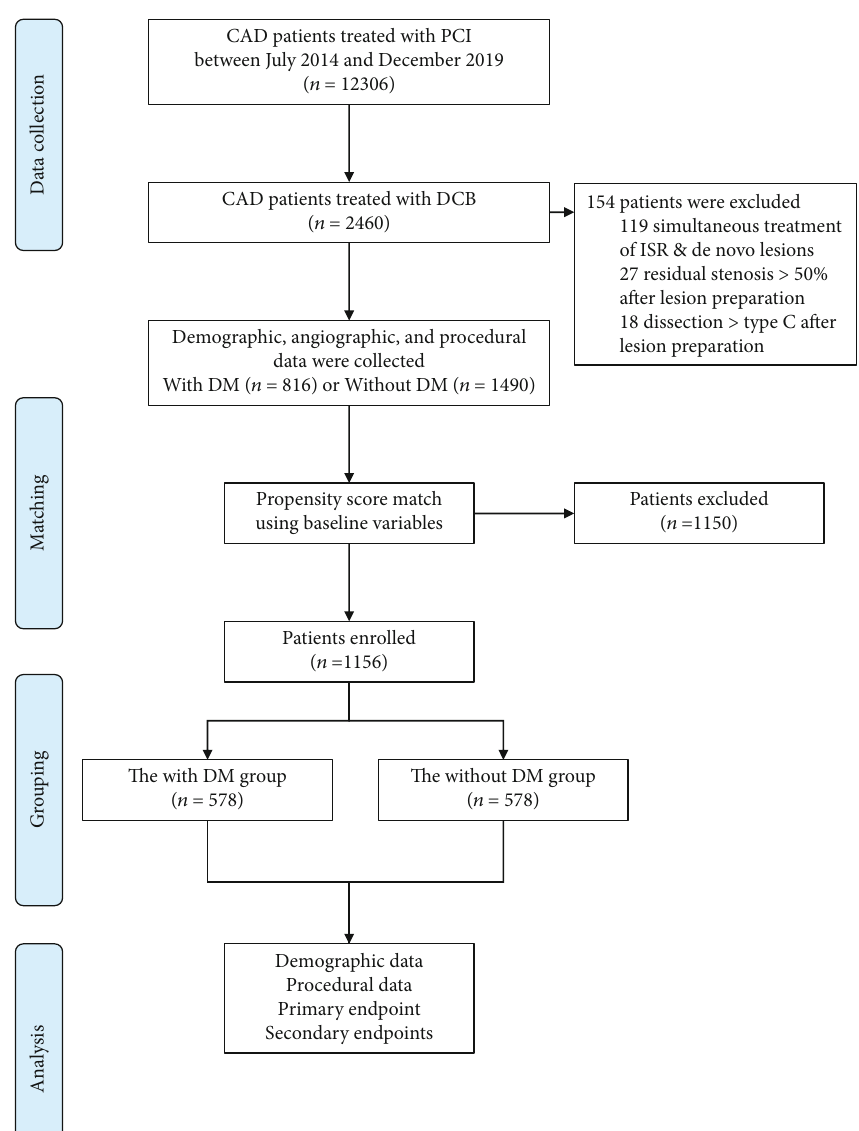
Figure 1: Study population. CAD: coronary artery disease; PCI: percutaneous coronary intervention; DCB: drug-coated balloon; DM: diabetes mellitus; ISR: instent